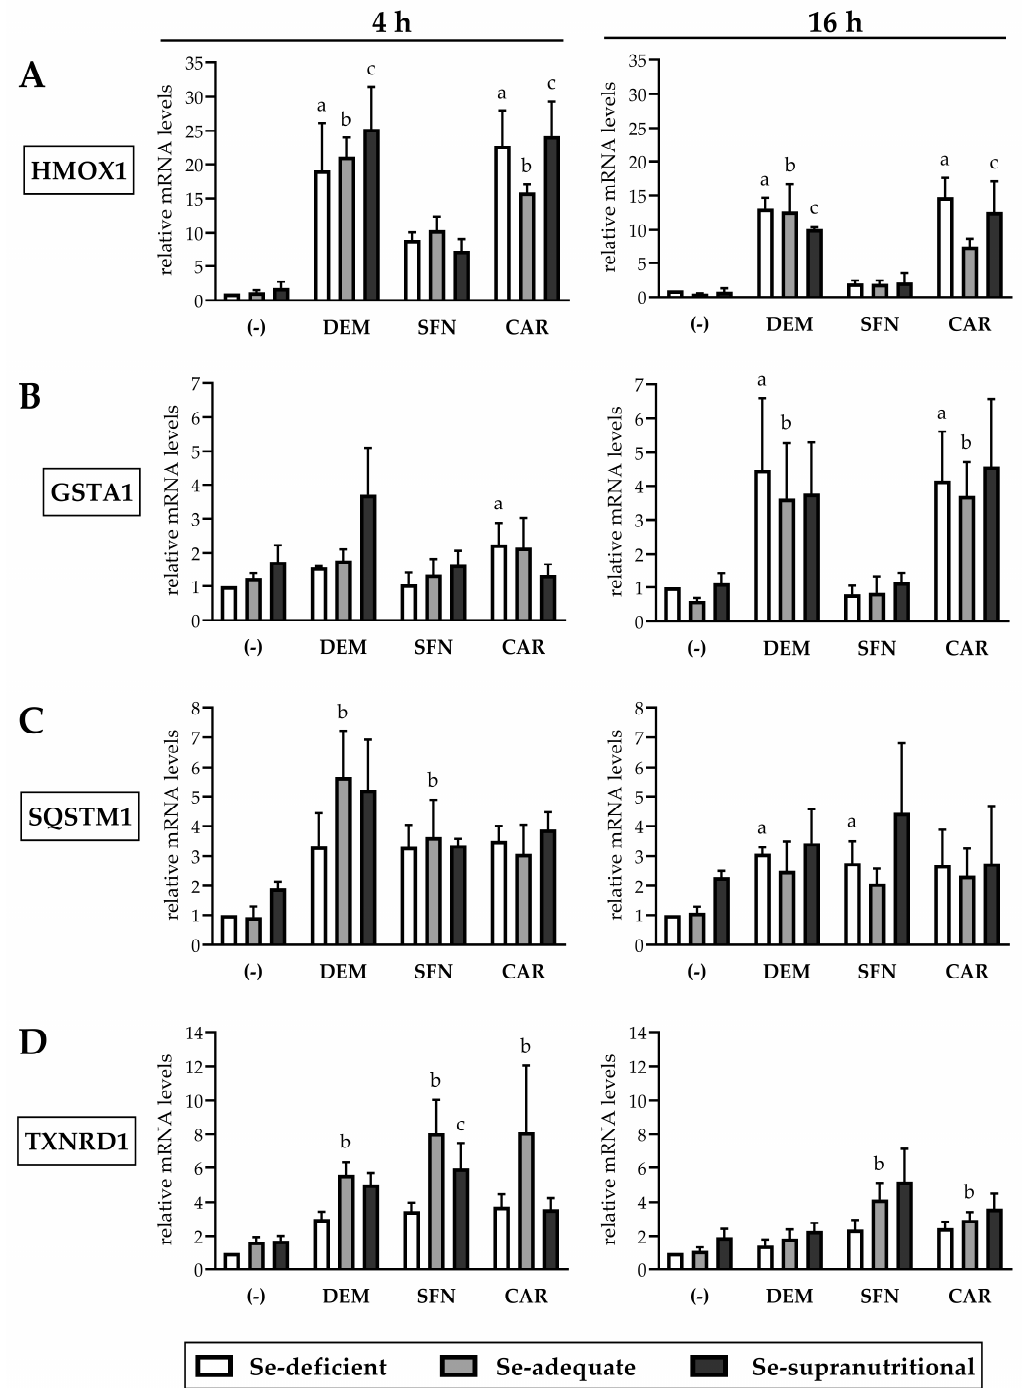
Figure 4. Electrophile-induced upregulation of Nrf2 target gene mRNAs is largely independent of the Se status of HepG2 cells. The cells were cultured for 16 h in serum-free medium without added Se (Se-deficient) or containing 0.1 µM selenite (Se-adequate) or 1 µM selenite (Se-supranutritional). Thereafter, cells were cultured for 4 h or 16 h in serum-free medium with the three different Se levels and 1 mM DEM, 50 µM SFN, or 50 µM CAR, respectively. As solvent control, the cells marked with (-) were treated with 0.1% DMSO. Relative mRNA levels of the Nrf2 targets HMOX1 ( A ), GSTA1 ( B ), SQSTM1 ( C ), and TXNRD1 ( D ) were determined by qRT-PCR, with normalization against HPRT1. Three independent experiments were performed; the data represent means ± S.E.M. Statistical analysis was done using the Friedman test and Dunn post hoc test, with statistical significance at p < 0.05: (a) significantly different from Se-deficient solvent control, (b) significantly different from Se-adequate solvent control, (c) significantly different from Se-supranutritional solvent